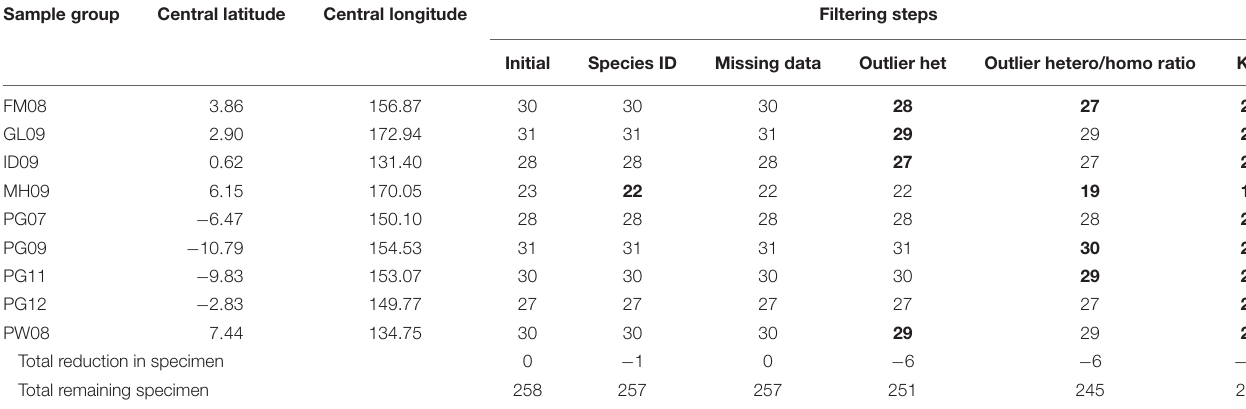
TABLE 1 | Initial population parameters and extraction of individuals during quality filtering. Sample group Central latitude Central longitude Filtering steps Initial Species ID Missing data Outlier het Outlier hetero/homo ratio